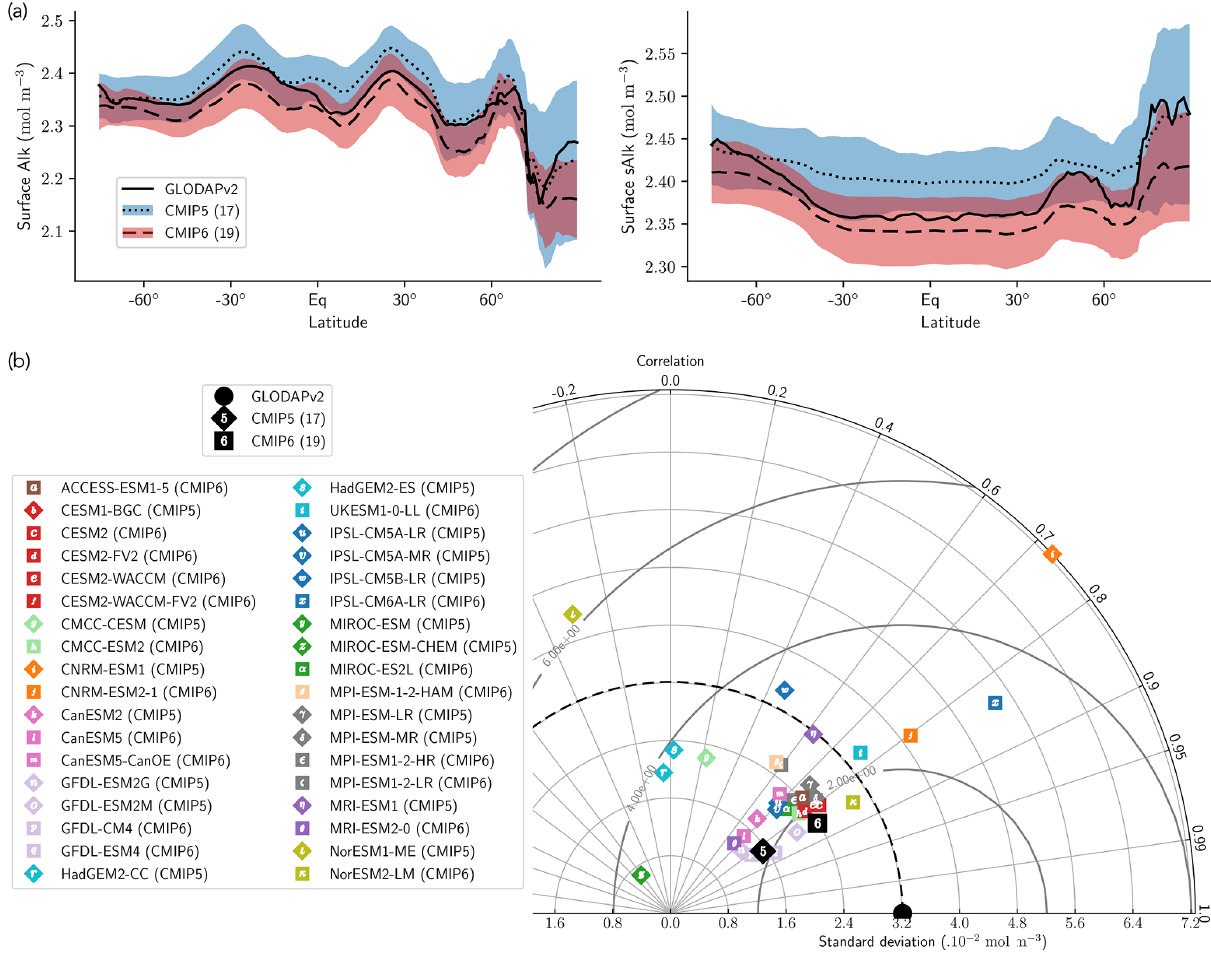
Figure 4. Spatial variability of surface Alk. (a) Open-ocean zonal mean surface Alk (left) and sAlk (right). The CMIP5 and CMIP6 ensemble mean and standard deviation are shown alongside GLODAPv2 observations. (b) Taylor diagram for the open-ocean surface distribution of sAlk. The reference corresponds to GLODAPv2 observations (black circle), and the black markers refer to the CMIP5 and CMIP6 ensemble means. The CMIP5 (CMIP6) ESMs are plotted with diamonds